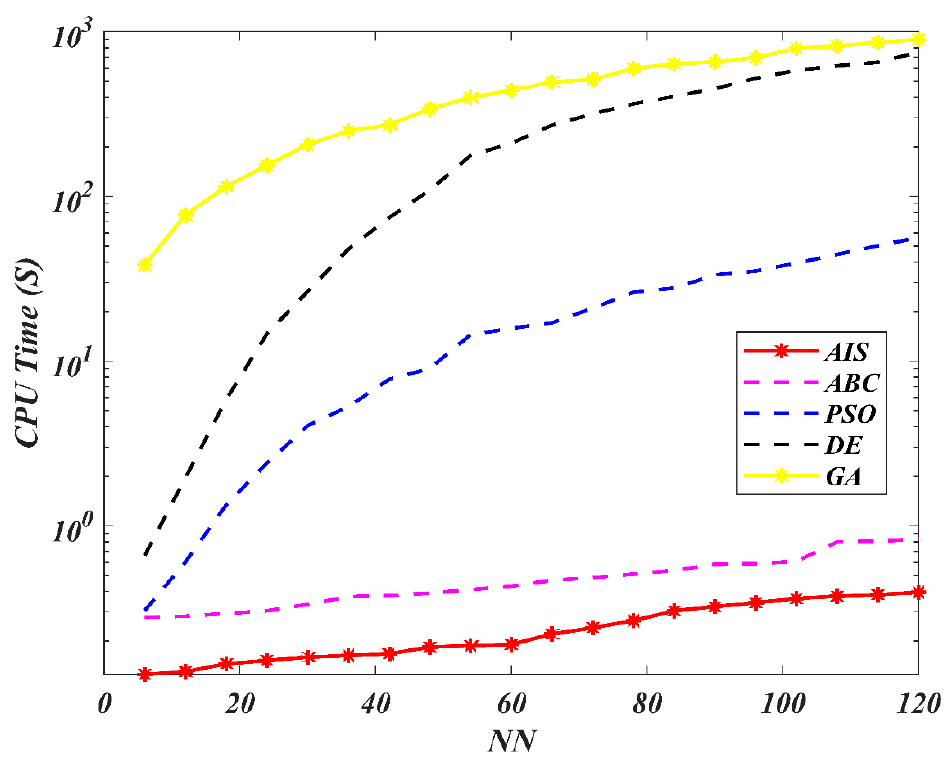
Figure 25. CPU time Evaluation for Congressional Voting Records.